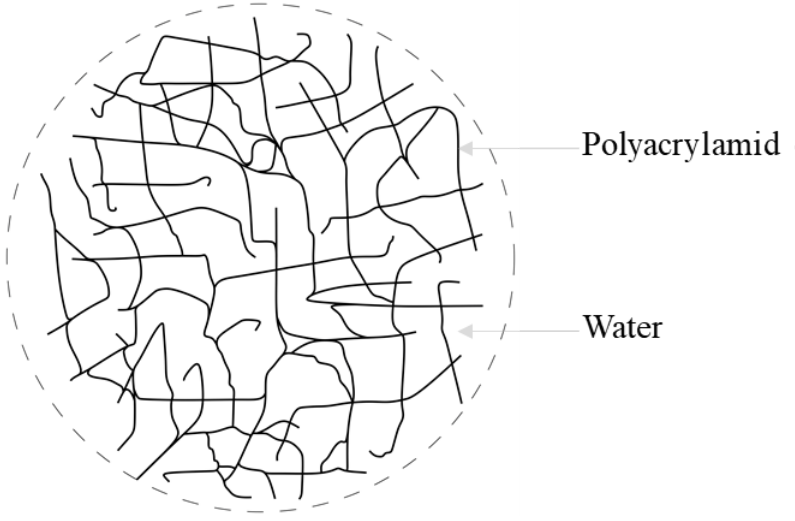
Figure 8. Micro-encapsulation of hydrated salt PCMs in polyacrylamide film [104]. Paraffin wax can also be encapsulated by forming an inorganic shell around it, e.g., a shell of calcium carbonate (CaCO3), using the self-assembly method shown schematically in Figure 9. First, oily paraffin is diffused in an aqueous solution, together with nonionic surfactants, to form a stable emulsion. Then, the chains of surfactants, which are hydrophobic by nature, are oriented to the oil droplets. At the same time, the hydroxyl groups of the surfactants, which are hydrophilic by nature, combine with the water molecules and stay away from the oil droplets. The layer of surfactants covers the surfaces of the oil droplets, forming kerosene micelles. Subsequently, Ca 2+ ions are bound by the hydroxyl groups of the surfactants when droplets of CaCl 2 are added to the same solution. This process is called the complexation process. Finally, CaCO 3 is formed because of a precipitation reaction by introducing Na 2 CO 3 into the same emulsion system. This CaCO 3 is not soluble in the system and acts as a shell encapsulating the oily phase (PCMs) of the emulsion. Since this CaCO 3 forms directly on the surface of the paraffin micelles, the process is referred to in the literature as the self-assembly process.